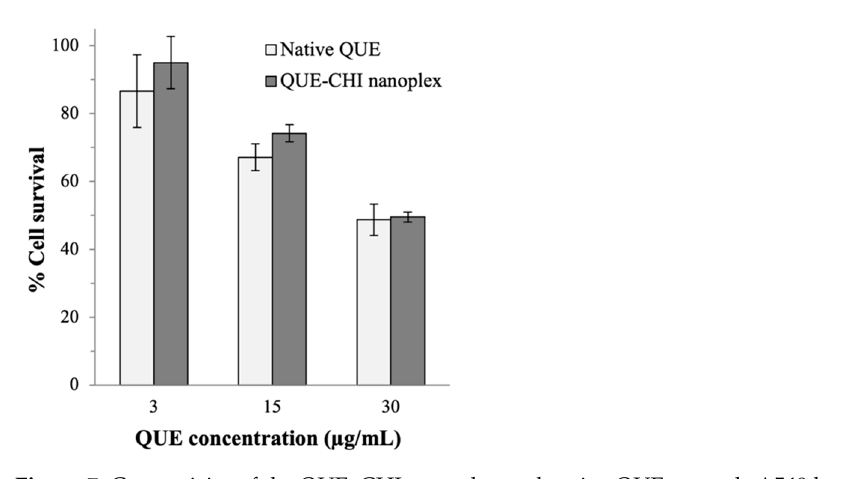
Figure 7. Cytotoxicity of the QUE–CHI nanoplex and native QUE towards A549 lung cancer cells